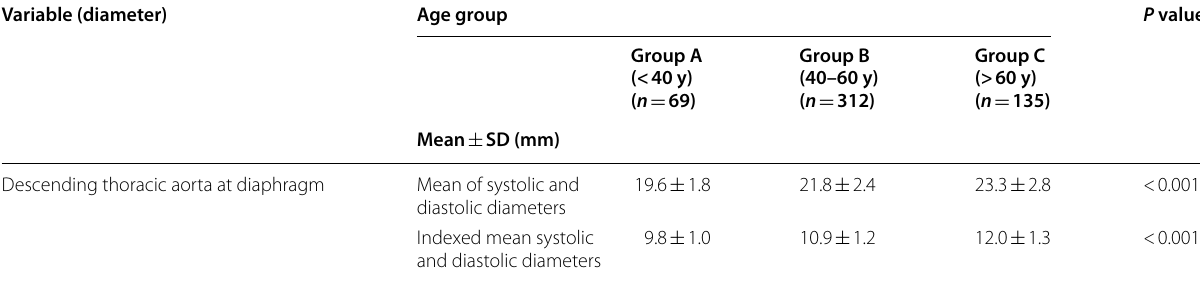
Table 13 Comparison of descending thoracic aortic diameters at the diaphragmatic level among different age groups: Variable (diameter)